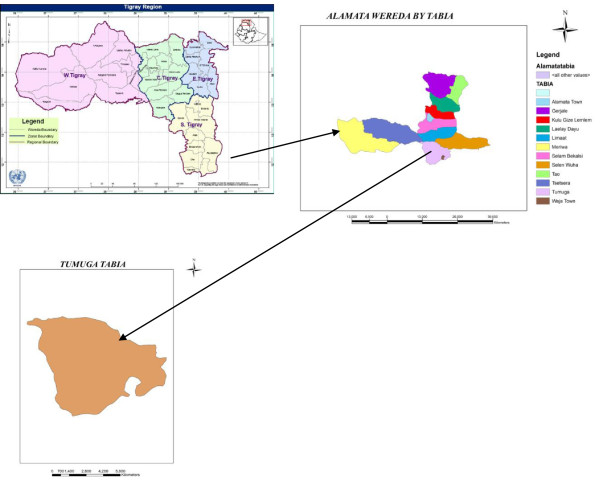
0 Map of study site.